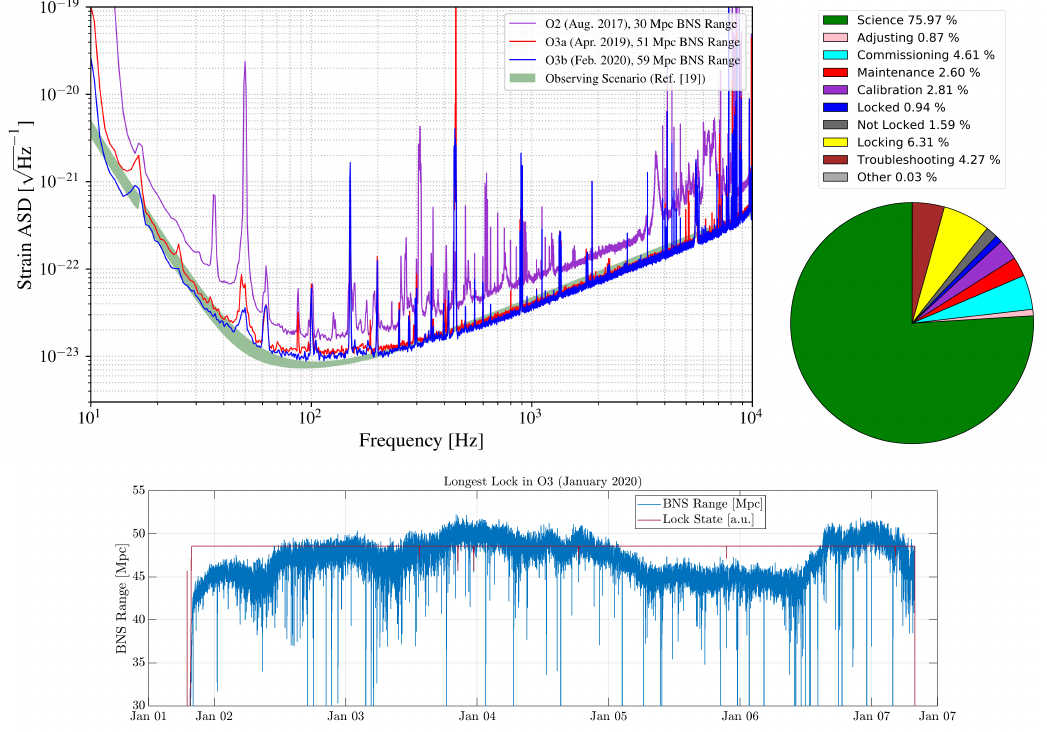
Figure 14. Snapshot of the performance of the Advanced Virgo detector in O3. Top Left: Sensitivity curve of Advanced Virgo in the two phases of the O3 Run, and comparison to the design sensitivity (Observing Scenario [19]) and the sensitivity during the O2 Run. Top Right: Overall duty cycle of Advanced Virgo during O3. Bottom: longest lock stretch of ≈ 132 h, from 1–7 January 2020, represented by the BNS Range and the Lock State flag of the